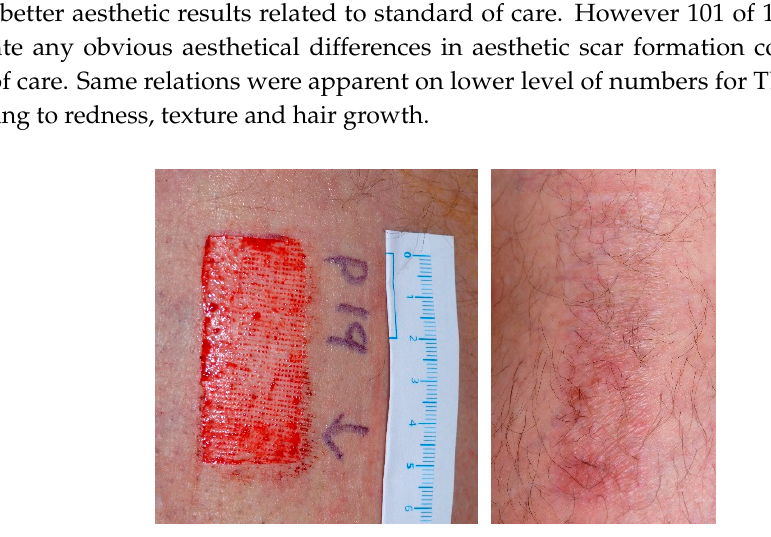
Figure 4. Typical clinical aspect of fresh skin graft wound just before starting TBG-treatment (upper half of the surgical site (left side) and 12 months postoperatively as clinically mature scar (right side) [27]. A total of 46 patients were asked for their personal assessment of aesthetic benefit after 1 year.